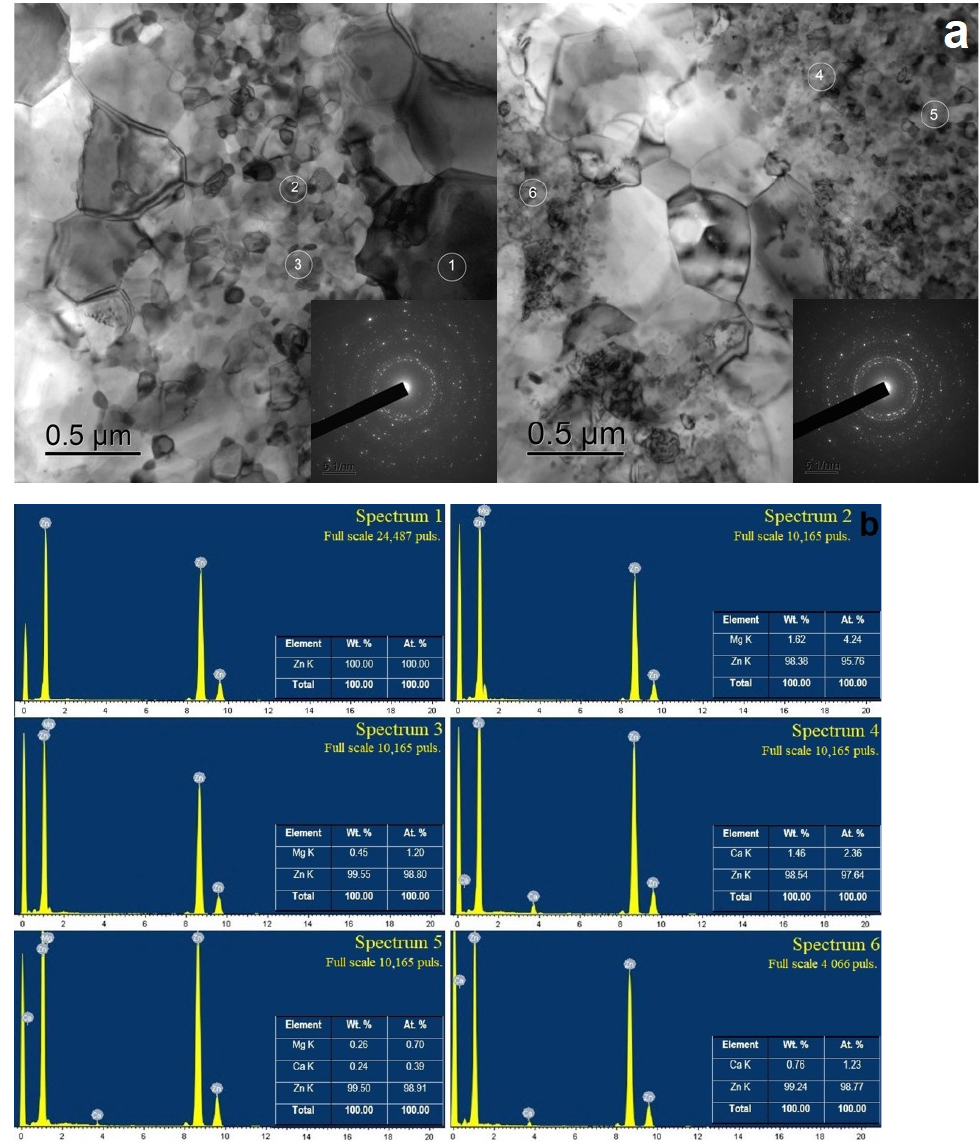
Figure 2. TEM images (bright field) of structure of the Zn-1%Mg-0.1%Ca alloy after HPT with SAED pattern (inset) ( a ) and TEM-EDS point analysis results of different zones of the Zn-1%Mg-0.1%Ca alloy ( b ).